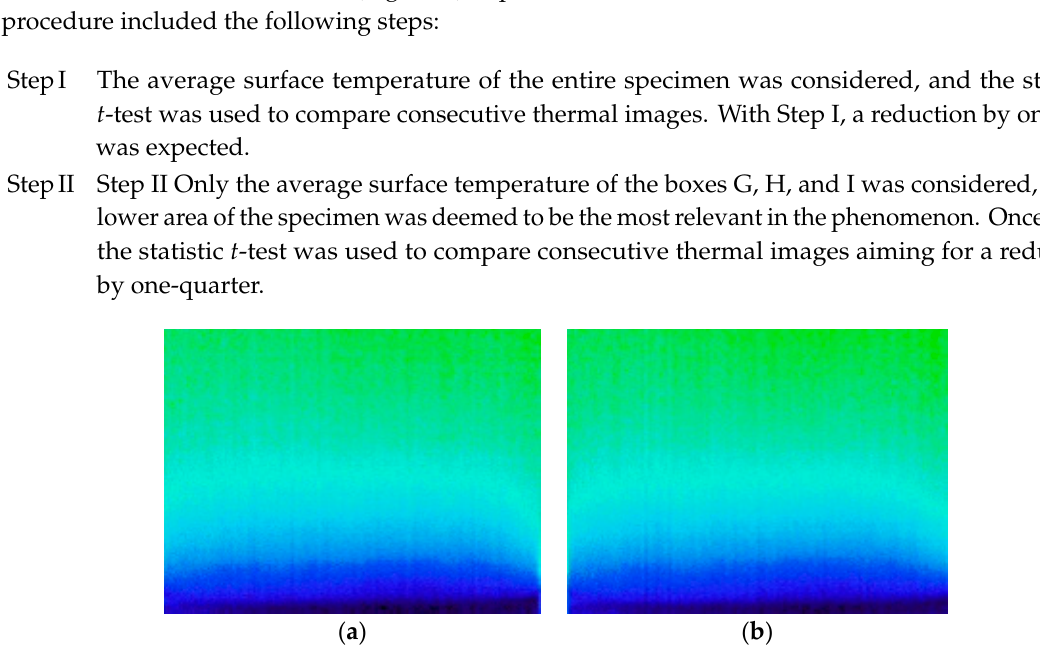
Figure 4. Thermal image of specimen during the humidification process: ( a ) t = 6 h; ( b ) t = 7 h.